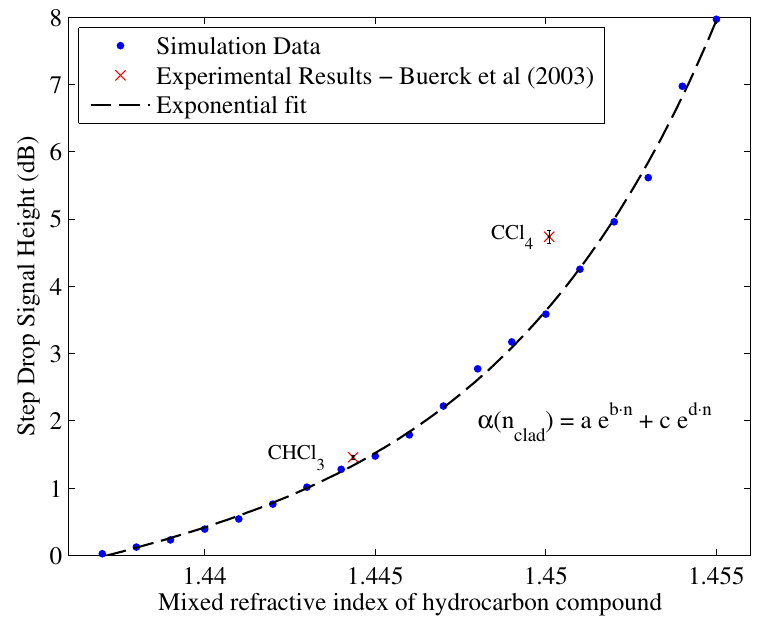
Figure 10. Expected step drop signal for various cladding RIs in comparison with experimental results [15].